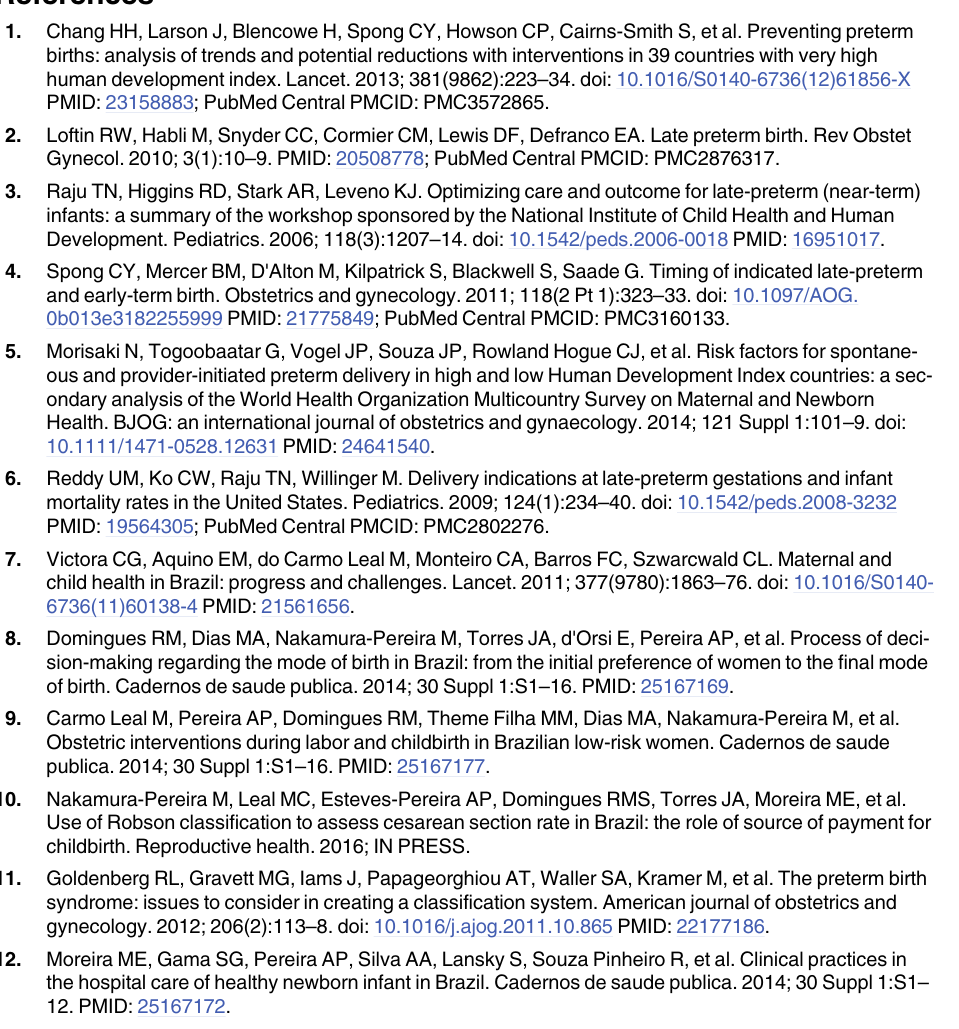
S2 Table. Preterm delivery according to gestational age and determining factor. Birth in Brazil study, 2011 –